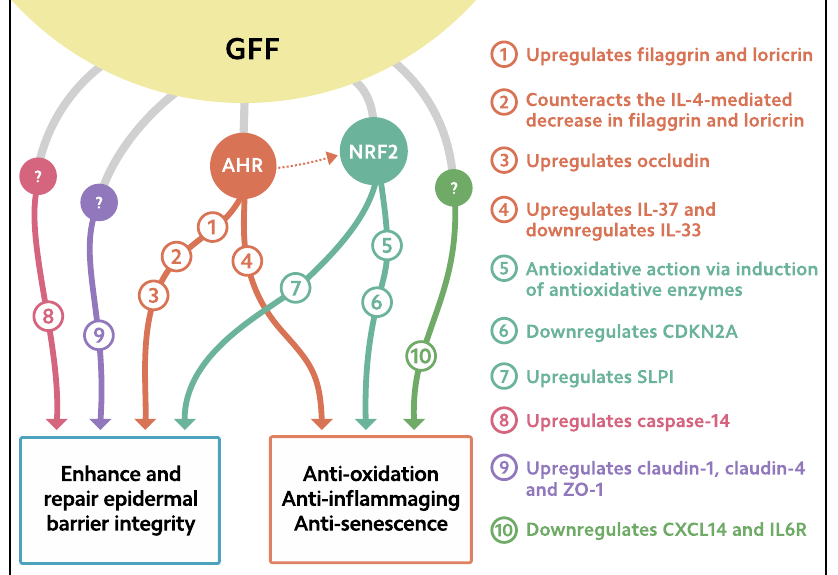
Figure 2. Biological response induced in keratinocytes treated with GFF. GFF: Galactomyces ferment filtrate. AHR: Aryl hydrocarbon receptor. NRF2: Nuclear factor erythroid 2-related factor 2. CDKN2A: cyclin-dependent kinase inhibitor 2A. CXCL14: chemokine (C-X-C motif) ligand 14. IL6R: IL-6 receptor. SLPI: secretory leukocyte peptidase inhibitor.